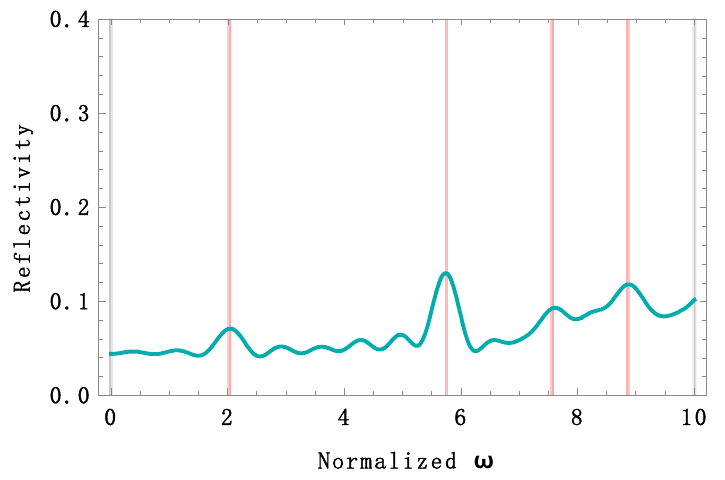
Figure 5. Theoretical reflectivity spectrum of the simulated barbule feather for TE, TM polarization, and incidence angle of 0 ◦ . Four high reflectivity bands (red lines) can be observed at 1237 nm, 437 nm, 333 nm, and 284 nm. The average reflectivity from 300 to 700 nm was 6.7 ± 2.3%, close to the experimental value of 6.4 ± 0.39% measured in [10]. A UV-chroma of 27% was calculated in the same range, and a UV-chroma of 24 ± 0.19% was reported in [10]. The normalized frequency is given by ω = 2 π ( dl + dm ) / λ .